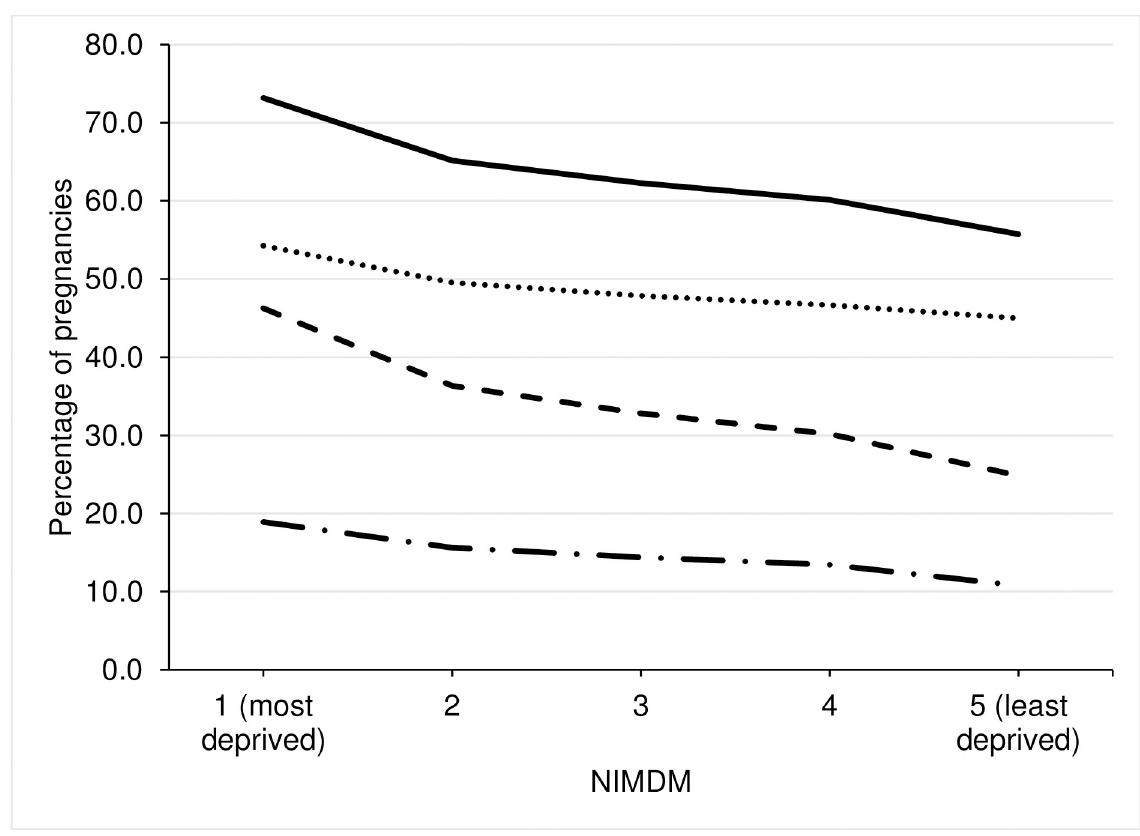
Fig 3. Percent of pregnancies with any medication, non-supplement medication, any supplements (vitamins, iron or folic acid) and only supplements recorded by NIMDM quintile. Solid black line = any medication; Dotted black line = non-supplement medication; Dashed black line = any supplements; Long dashed black line = only